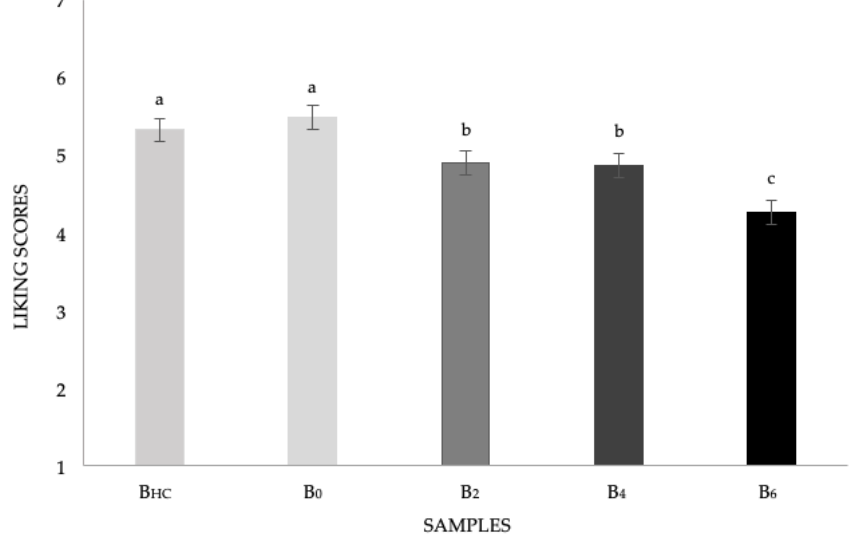
Figure 1. Mean liking scores ± SEM by samples. Different letters indicate significant differences